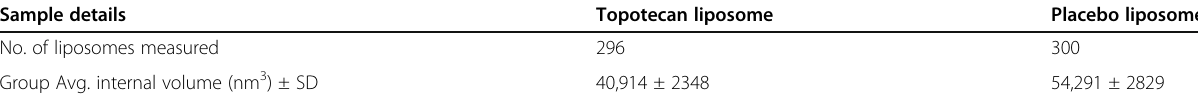
Table 7 Internal volume results of topotecan liposome and placebo liposome